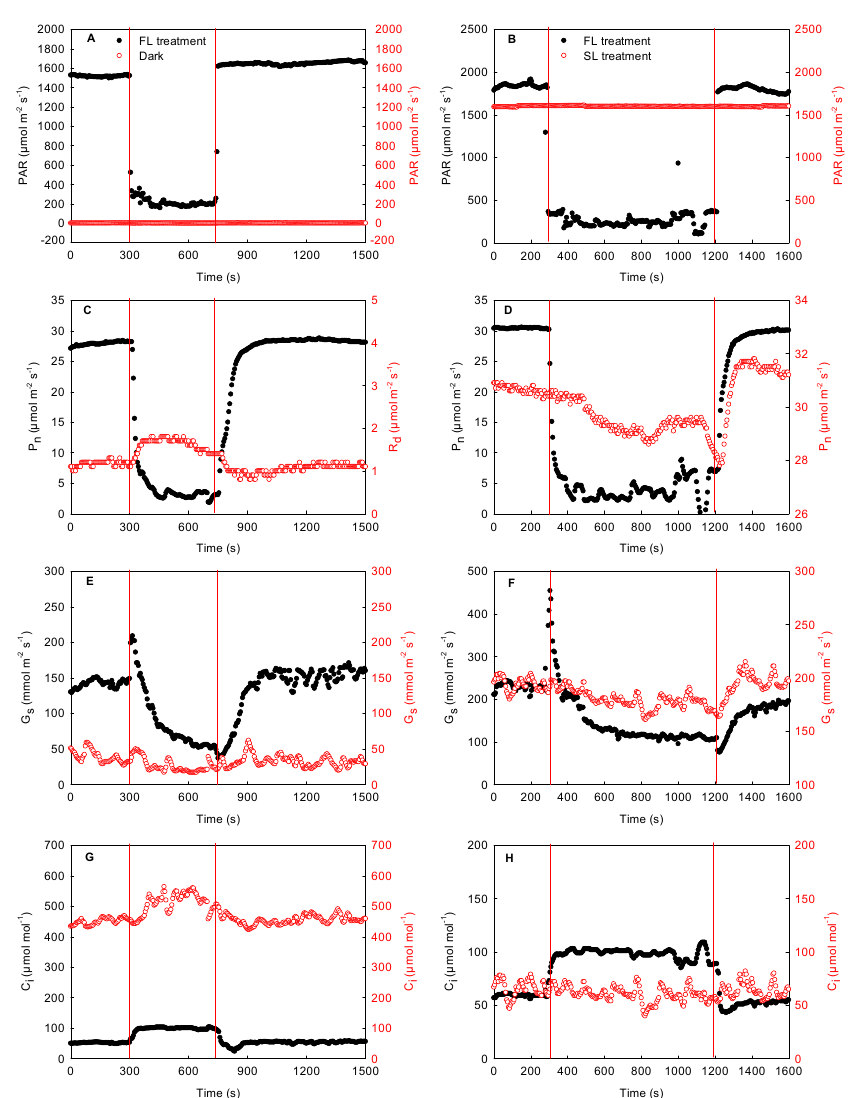
Figure 8. Effects of fluctuating light intensity in local regions on the respiration rate and photosynthetic rate of adjacent region in the same maize leaves in the field. ( A ) light intensity under natural fluctuating light in the local regions or in darkness in the adjacent region; ( B ) light intensity under natural fluctuating light in the local regions or under steady light intensity in the adjacent region; ( C ) photosynthetic rate under natural fluctuating light in the local regions or respiration in darkness in the adjacent region; ( D ) photosynthetic rate under natural fluctuating light in the local regions or under steady light intensity in the adjacent region; ( E ) stomatal conductance under natural fluctuat- ing light in the local regions or in darkness in the adjacent region; ( F ) stomatal conductance under natural fluctuating light in the local regions or under steady light intensity in the adjacent region; ( G ) intercellular CO 2 concentration under natural fluctuating light in the local regions or in darkness in the adjacent region; ( H ) intercellular CO 2 concentration under natural fluctuating light in the local regions or under steady light intensity in the adjacent region. C i , intercellular CO 2 concentration; FL treatment, fluctuating light treatment; G s , stomatal conductance; PAR, photosynthetically active radiation; P n , photosynthetic rate; R d , respiration in darkness; SL treatment, steady light